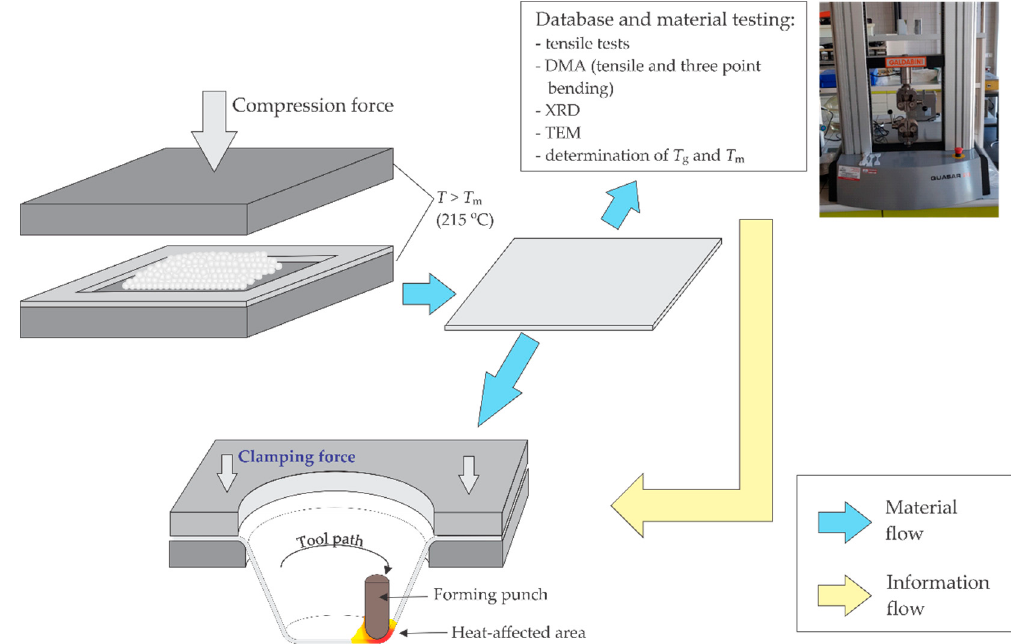
Figure 1 . Schematic representation of the preparation of polyamide (PA) 12/clay nanocomposite Figure 1. Schematic representation of the preparation of polyamide (PA) 12 / clay nanocomposite sheets sheets suitable for the single point incremental forming (SPIF) process. suitable for the single point incremental forming (SPIF)